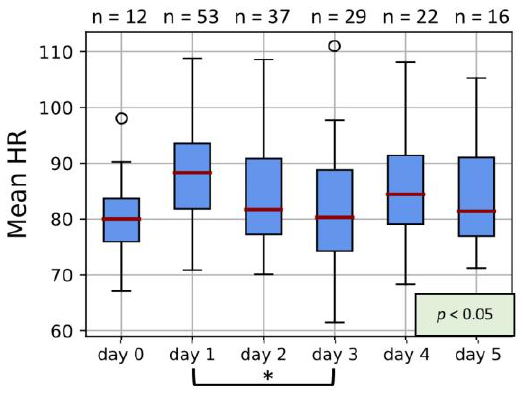
Figure A3. Boxplots of the HR of participants on days 0 to 5 , excluding all participants who were also administered anti-hypertensive medications. Boxplots represent the median, interquartile range, and interdecile range of the values. Day 0 represents measurements taken before the first injection of betamethasone, while day 1 represents 24 h after the first injection, day 2 represents 48 h after the first injection, etc. * represents a statistically significant finding with p < 0.05. The number of measurements incorporated into each day is displayed at the top of the graph.